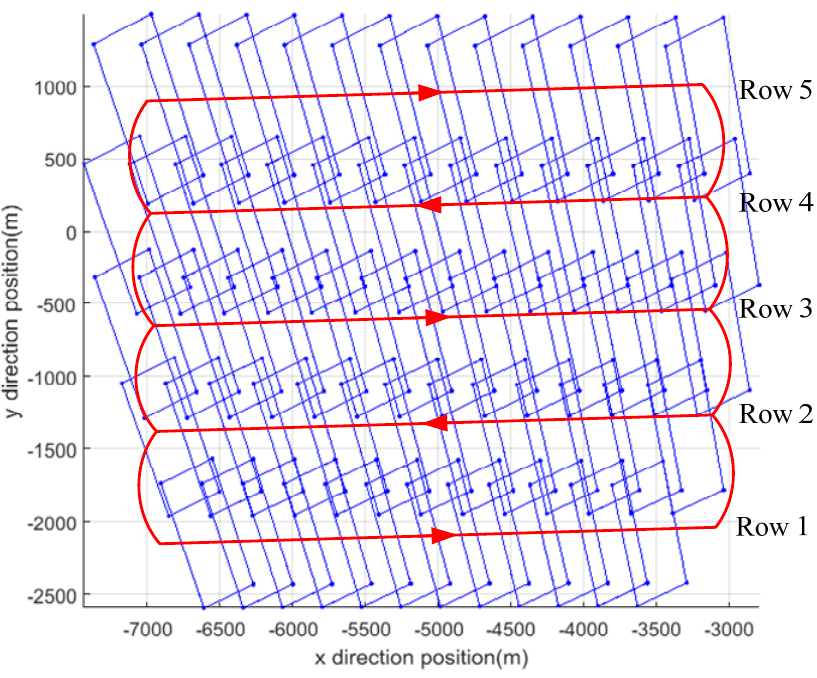
Figure 11. The ground imaging projection map in search mode.